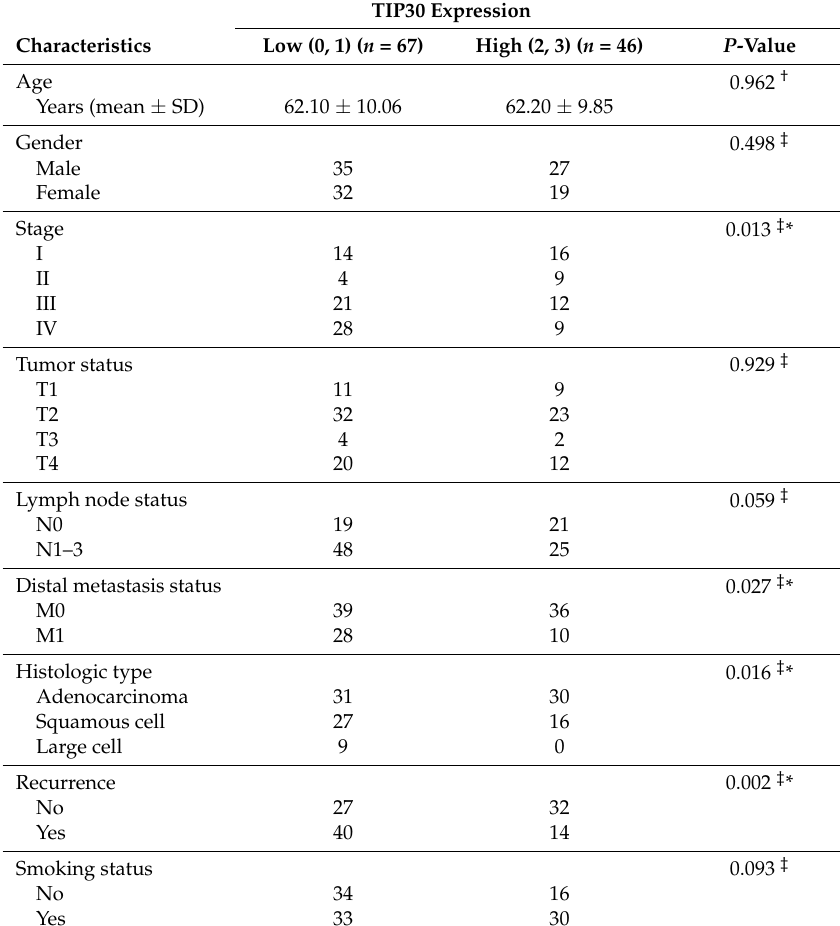
Table 3. Demographics and characteristics of the patients and the association of TIP30 expression and clinicopathological